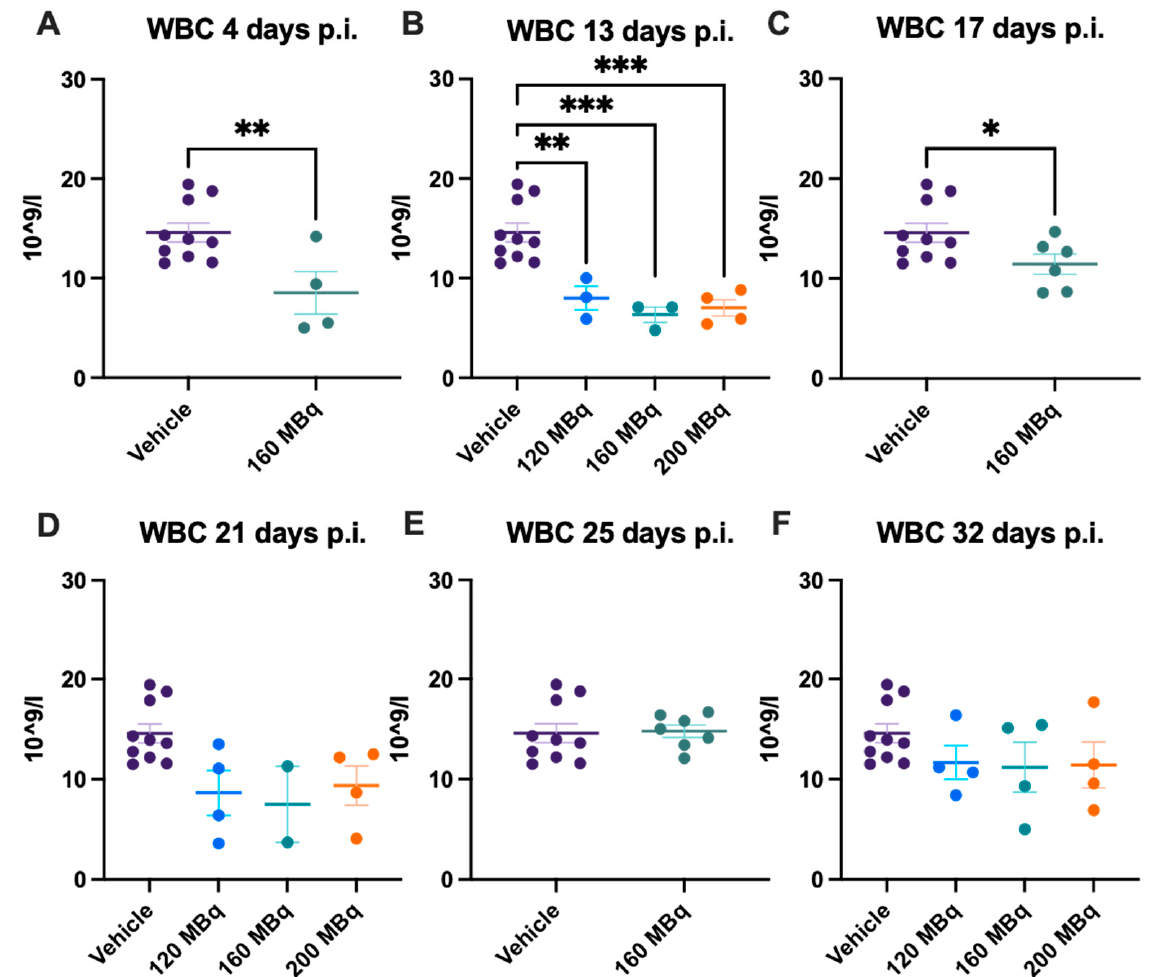
Figure 1. White blood cell (WBC) count after 4 ( A ), 13 ( B ), 17 ( C ), 21 ( D ), 25 ( E ), and 32 days ( F ) post injection of 120 MBq ( B , D , F ), 160 MBq ( A – F ), or 200 MBq ( B , D , F ). Values are presented as individual plots with group mean ± SEM. Differences between groups were analyzed using an unpaired t -test ( A , C , E ) or one-way ANOVA with post-hoc Tukey ( B , D , F ). * p < 0.05, ** p < 0.01, *** p < 0.001. After 17 days, the 160 MBq group still had lower WBC (Figure 1C) and lymphocytes (Figure 2C), but the monocytes and granulocytes had recovered to a similar level as control animals (Figure 2I,O). At 21, 25, and 32 days, there were no significant differences between control and animals receiving 177 Lu-PSMA-617 (Figures 1D–F and 2J–L,P–R), suggesting no long-lasting hematotoxicity. Overall, there was no correlation between activity received and decrease in white blood cells at the different time points, not when correcting for body mass differences either (Supplementary Figure